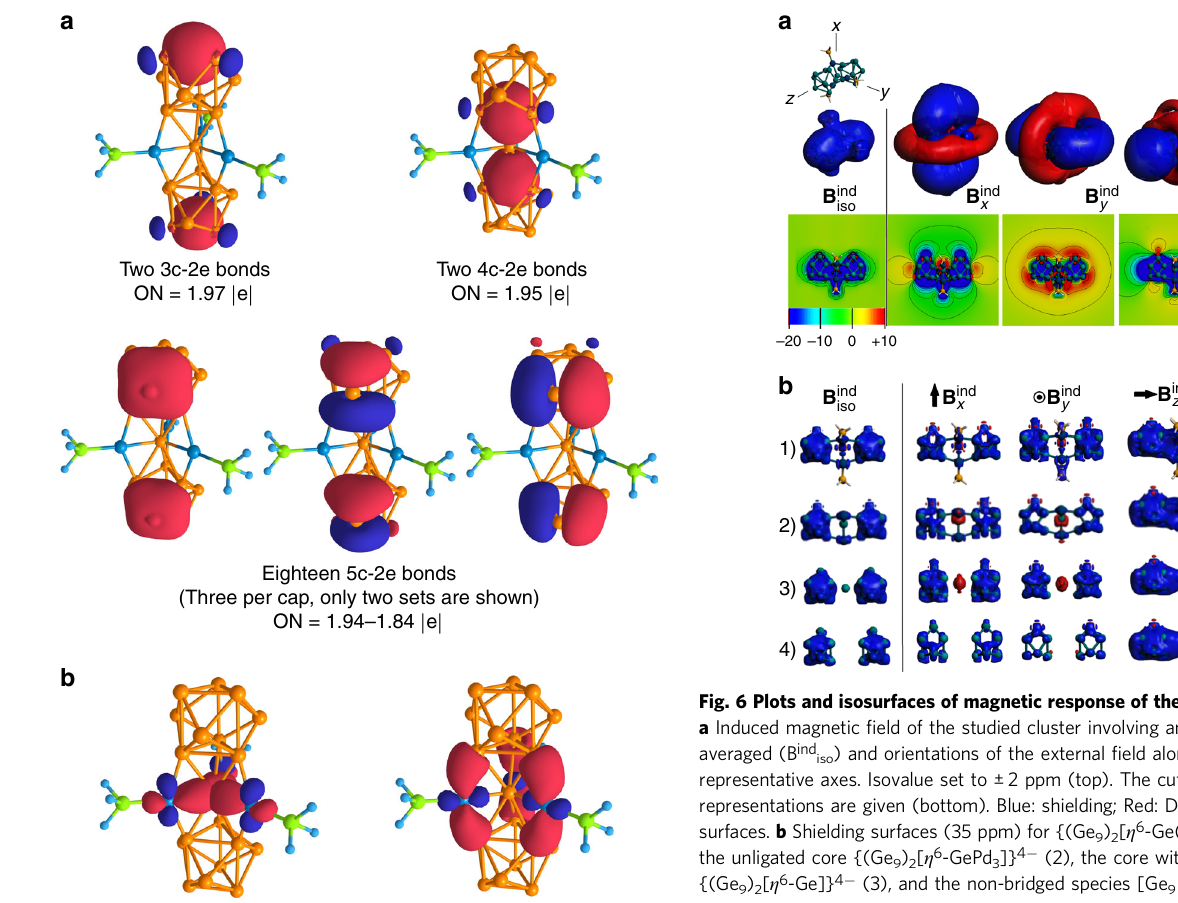
Three 2c-2e Pd-Ge σ -bonds ON = 1.95 ⎪ e ⎪ Fig. 5 The result of AdNDP analysis of the selected fragments of the cluster-1. a Multicenter bonds of {(Ge 9 ) 2 [ η 6 -Ge(PdPH 3 ) 3 ]} 4 − . b Localized 2c – 2e bonds of {(Ge 9 ) 2 [ η 6 -Ge(PdPH 3 ) 3 ]} 4 − .